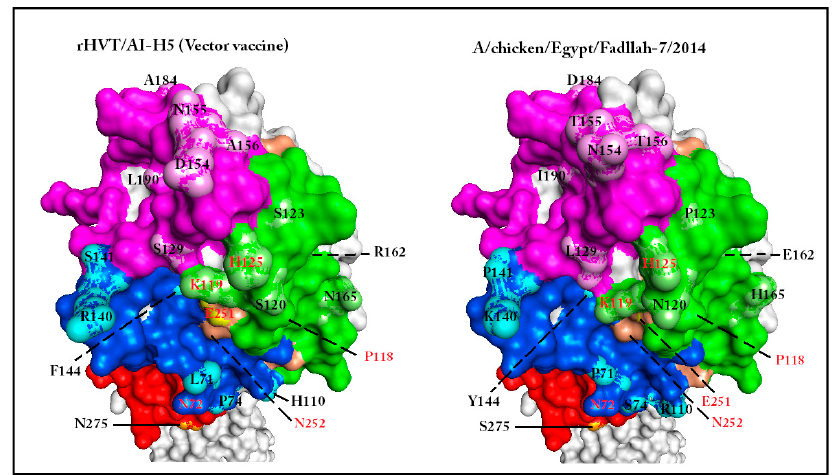
Figure 2. The effect of amino acid mutations in or around vulnerable sites on the AIV HA1 solvent surface topology. Three-dimensional models of whole hemagglutinin (HA) molecules were generated using Phyre2 (a web portal for protein homology-based modeling, prediction, and analysis) [36,45]. Modeled structures were visualized using Accelrys ® Discovery Studio v4.1 software (Dassault Systèmes BIOVIA Corp., San Diego, CA, USA) using solvent surface structure view. The different models were synchronized to unify orientation. Only the HA1 globular head and part of the stalk are shown. Sequence elements involved in VS formation were colored green, magenta, blue, and red according to the original coloring code of VS1-4, respectively [17]. The linear epitope sequences [28] were colored bronze. The locations of amino acid mutations and/or surface alterations were highlighted using a bright coloration of background of each region. When comparing each case, the mutated amino acids were indicated by solid lines on the 3D model. Amino acid identifications in red indicate positions showing surface alterations without amino acid mutations. Dashed lines indicate the position of amino acid mutations that are not exposed in the present view. The presented view of the 3D models illustrate that specific substructures of the molecule exhibit conserved confirmation with or without mutation. Other substructures show topology variations due to mutations in or around the substructure.